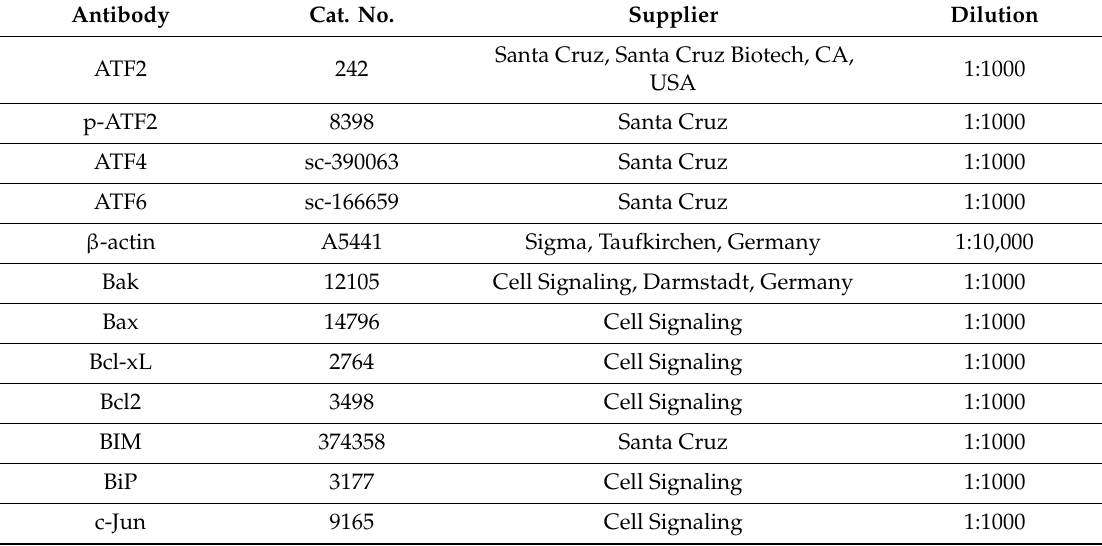
Table 2. Antibodies used in this